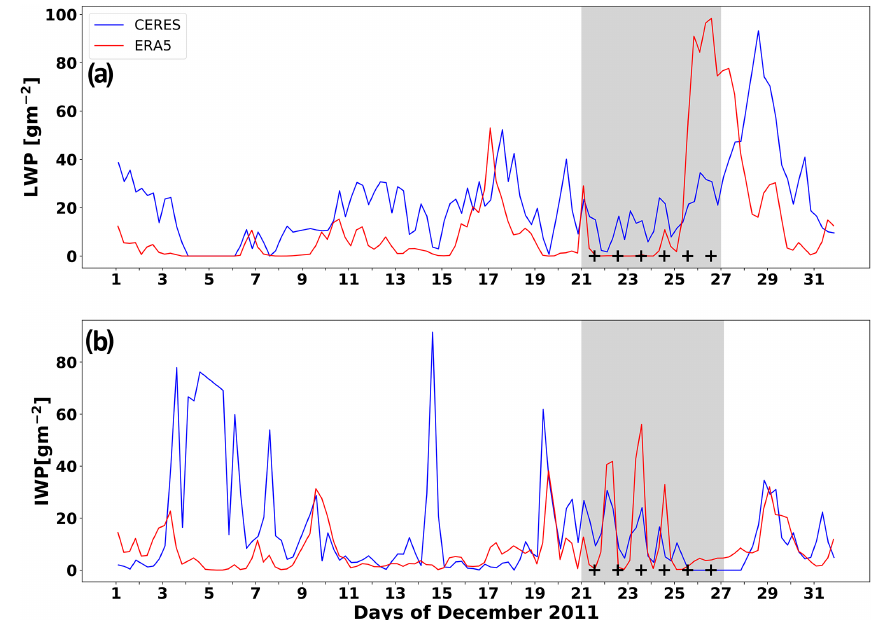
Figure 22. As in Fig. 5 but over the Siple Dome region throughout December